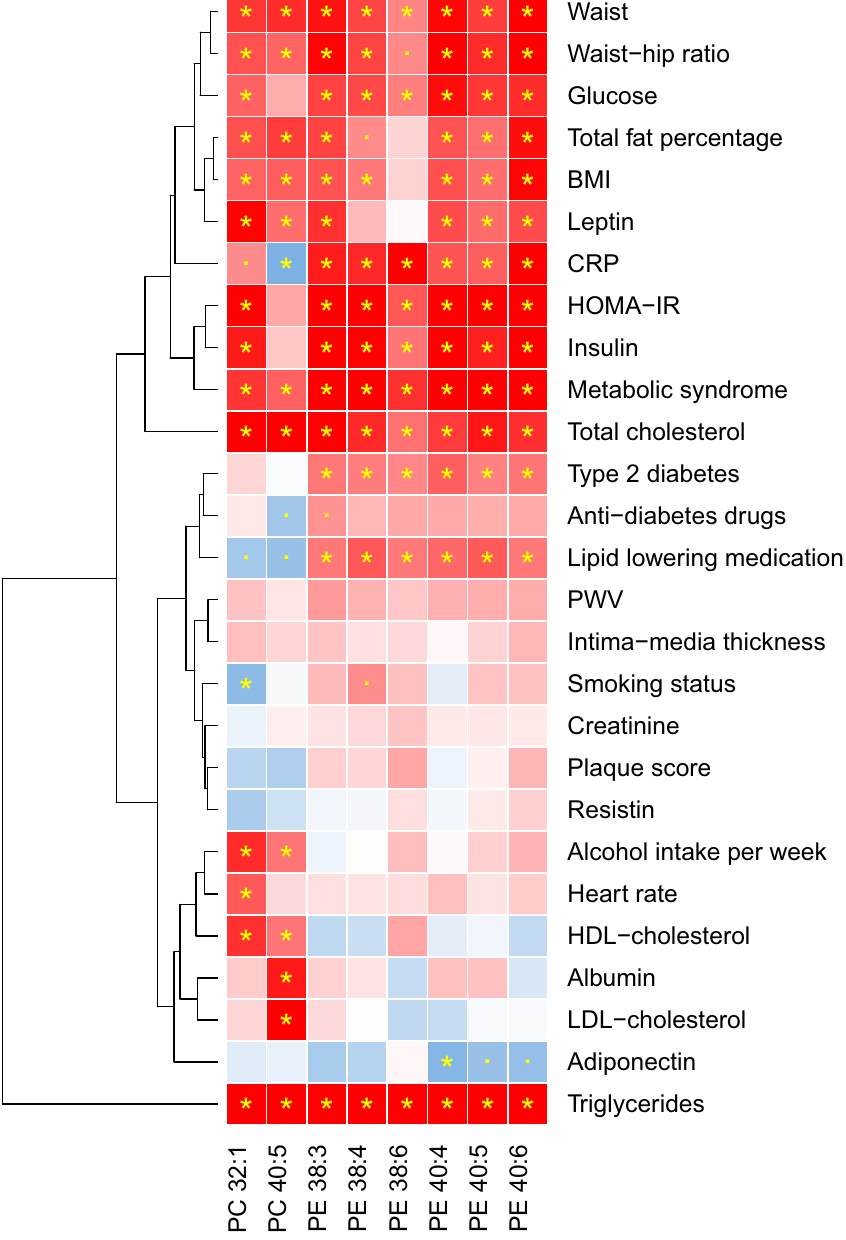
Figure 4. Association of blood pressure related phospholipids and cardiometabolic traits in ERF. Hierarchical clustering approach was used for the clustering. Red: positive association; blue: negative association. The depth of the color displays the strength of z score in the regression. * FDR < 0.05. · P -value <